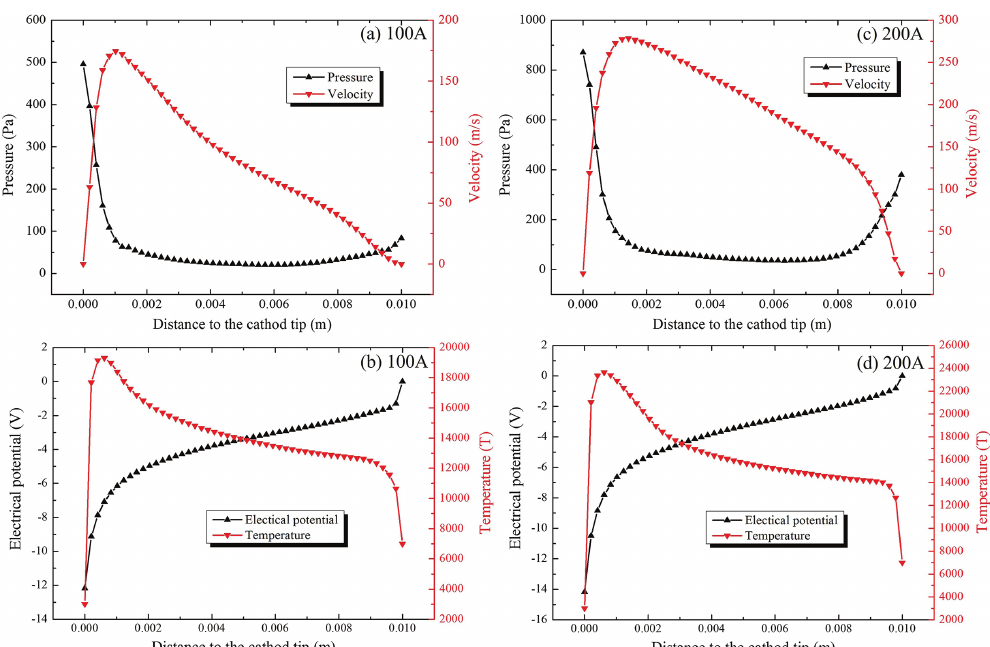
Figure 5: Pressure and fluid flow fields in arc region at (a) 100 A and